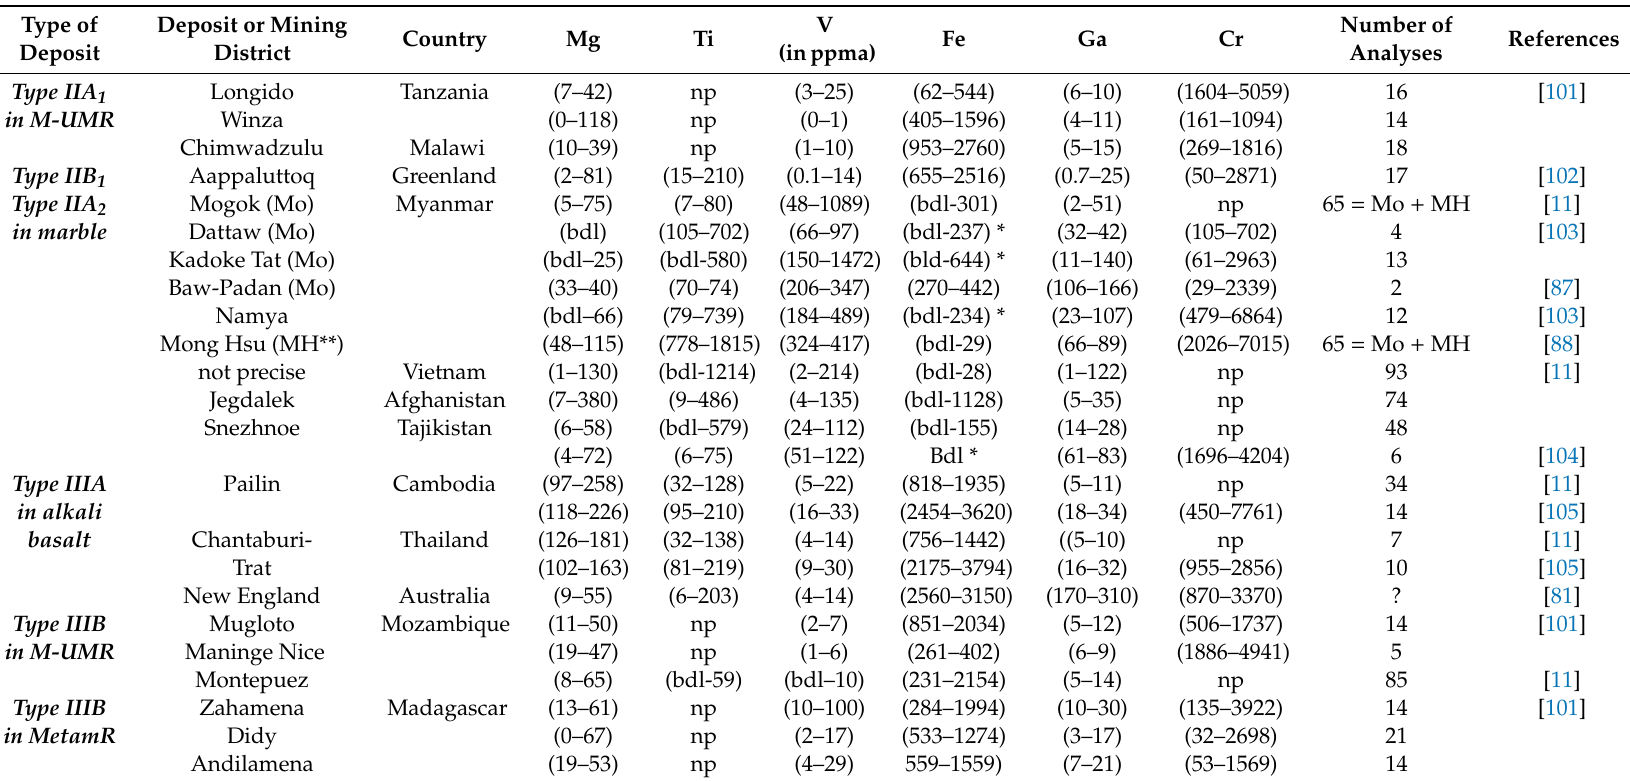
Table 2. Representative analyses (in ppm) obtained by LA-ICP-MS of rubies originating from deposits of di ff erent geological types relative to the new enhanced geological classification for